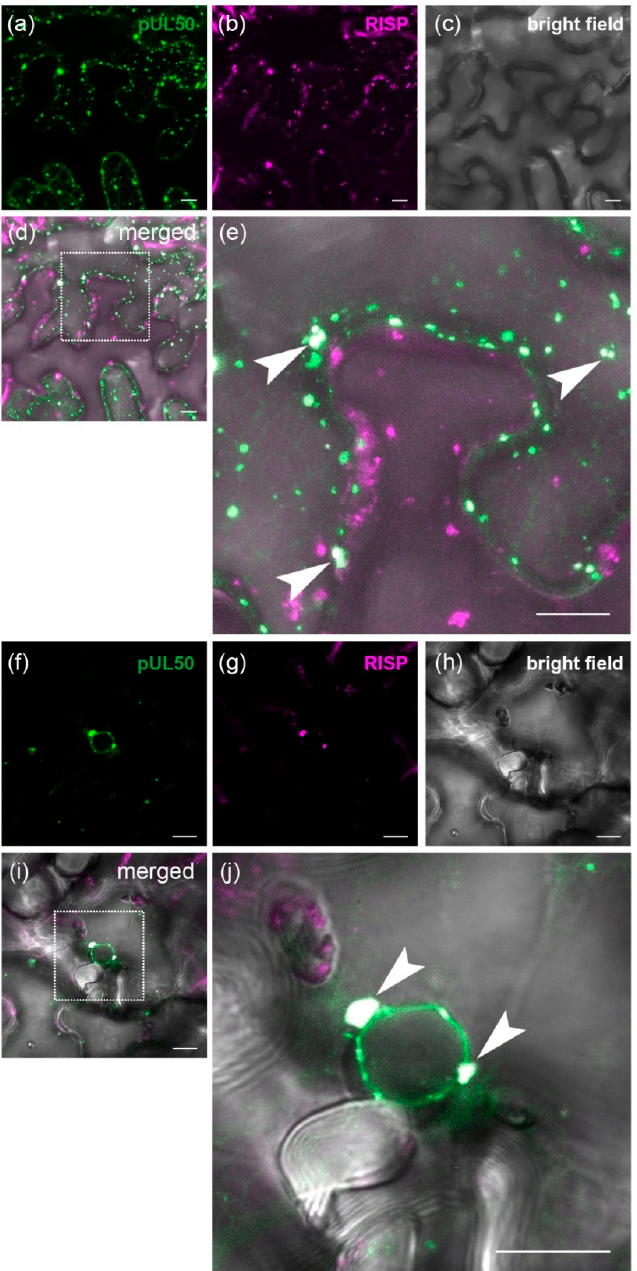
Figure 5. Colocalization studies of eGFP::pUL50 (depicted in green) and RISP::tagRFP (depicted in magenta). ( a ) Note that upon coexpression, eGFP::pUL50 was found retained in cytoplasmic aggregates; ( b ) As reported earlier [63], RISP::tagRFP was mainly localized to cytoplasmic dot-like structures; ( d ) The merged image demonstrates colocalization of eGFP::pUL50 and RISP::tagRFP. The dotted box indicates the section magnified in ( e ); ( e ) Magnified section from ( d ), arrowheads point towards ( f ) During coexpression with RISP::tagRFP, eGFP::pUL50 still localized to the nuclear rim, in